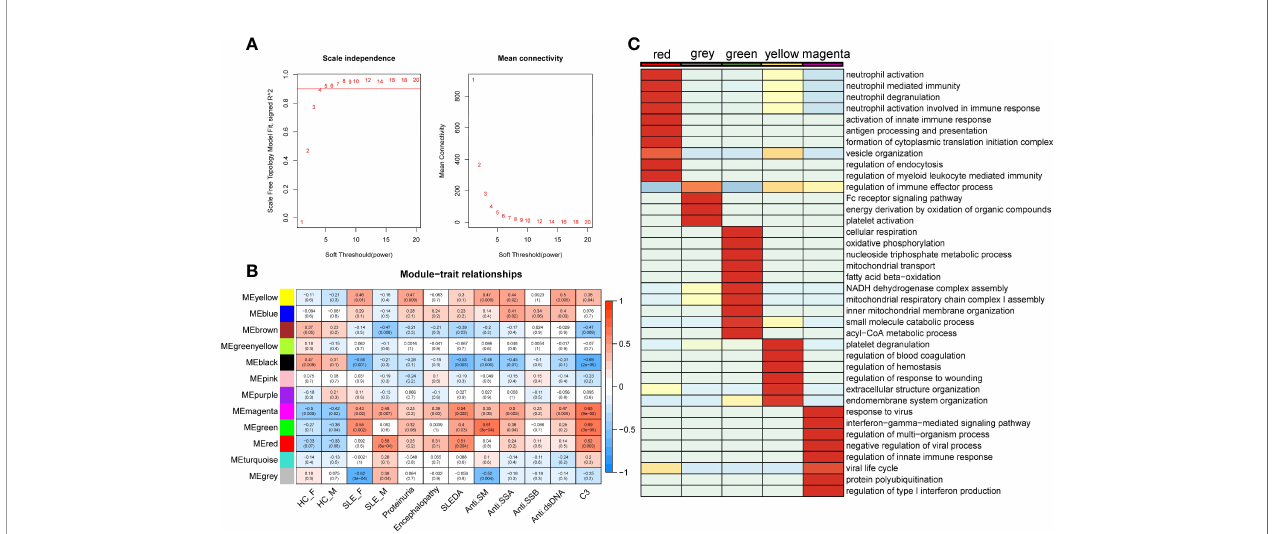
FIGURE 2 | SLE-associated modules and their functional meaning. (A) Summary network indices (y-axes) as functions of the soft thresholding power. (B) Relationships of consensus module eigengenes and clinical traits. Numbers in the table report the correlations of the corresponding module eigengenes and traits, with the p-values printed below the correlations in parentheses. (C) Heatmap comparing enrichment p-value of pathway among fi ve modules. The stronger the red color, the more signi fi cant the p-value